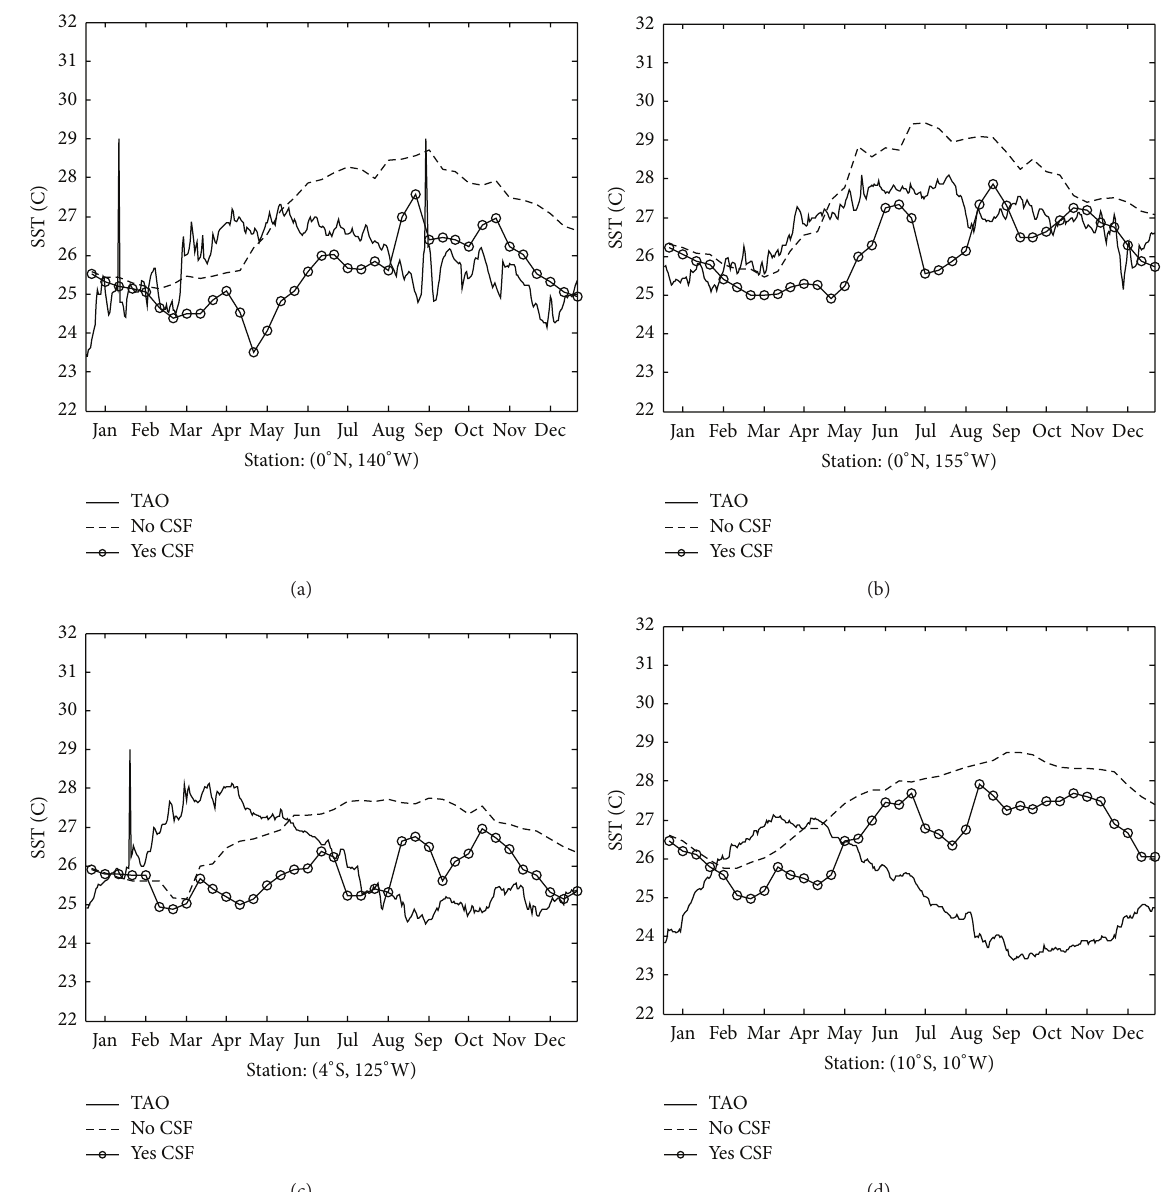
Figure 5: Daily SST ( ∘ C) time series in 2001 from TAO buoys (solid line) and those output from HYCOM simulations with CSF (cycle line) and without CSF (dash line) for 4 stations at equatorial Pacific, (0 ∘ N, 140 ∘ W), (0 ∘ N, 155 ∘ W), (5 ∘ S, 125 ∘ W), and (10 ∘ S, 10 ∘